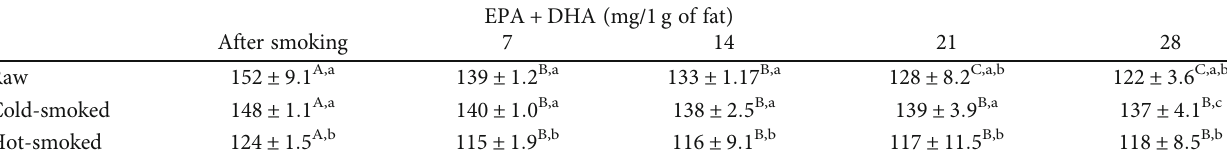
a, b, c: signi fi cant di ff erences ( n = 3 ) between individual treatments within one storage time; A, B, C: signi fi cant di ff erences ( n = 3 ) between treatments during